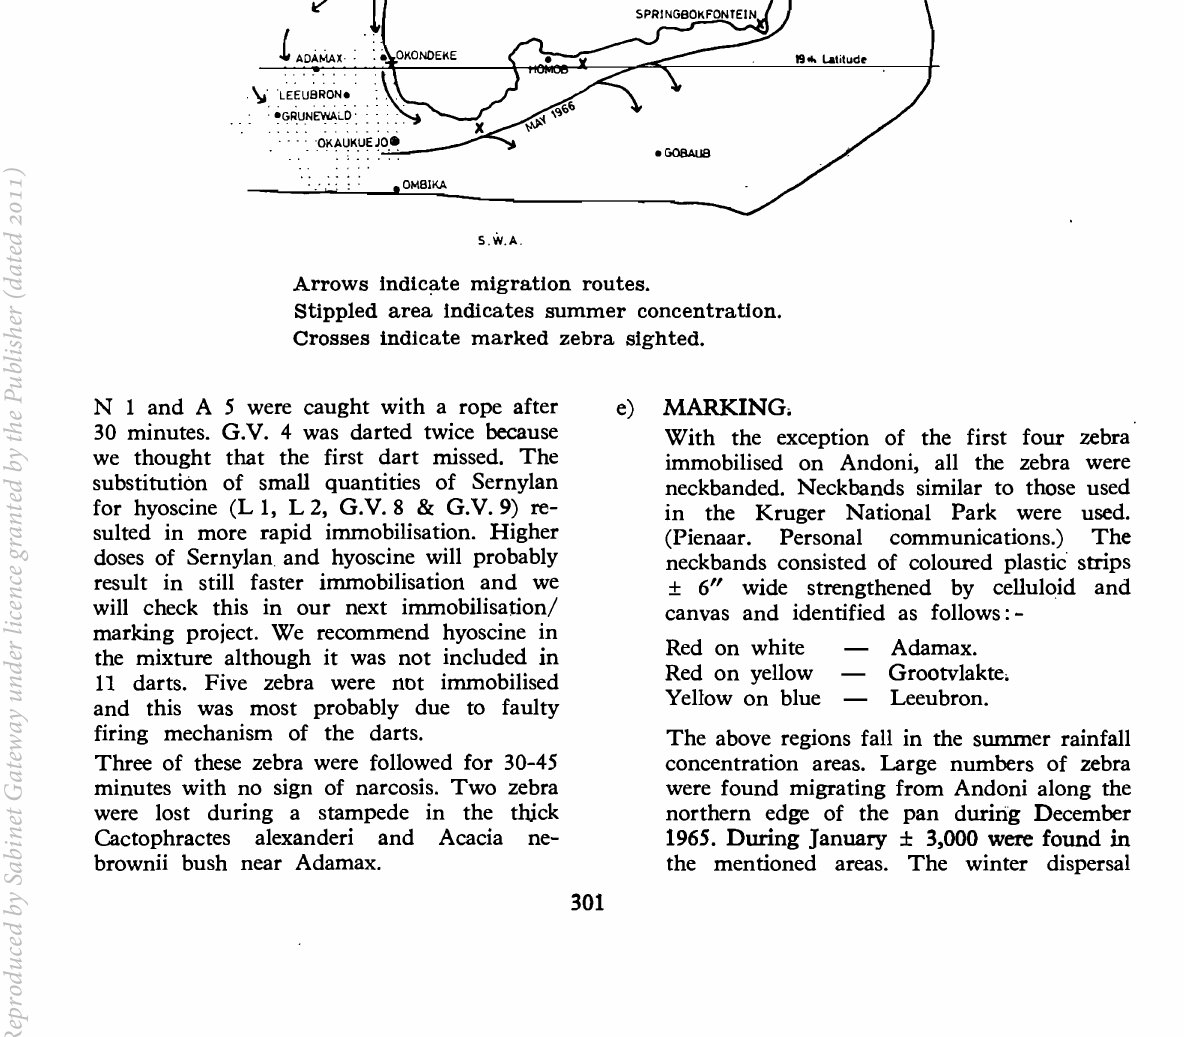
Arrows indicate migration routes. Stippled area indicates summer concentration. Crosses indicate marked zebra